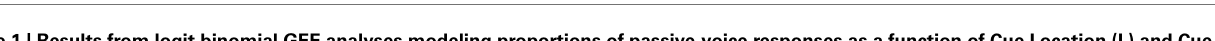
Table 1 | Results from logit binomial GEE analyses modeling proportions of passive-voice responses as a function of Cue Location (L) and Cue Type